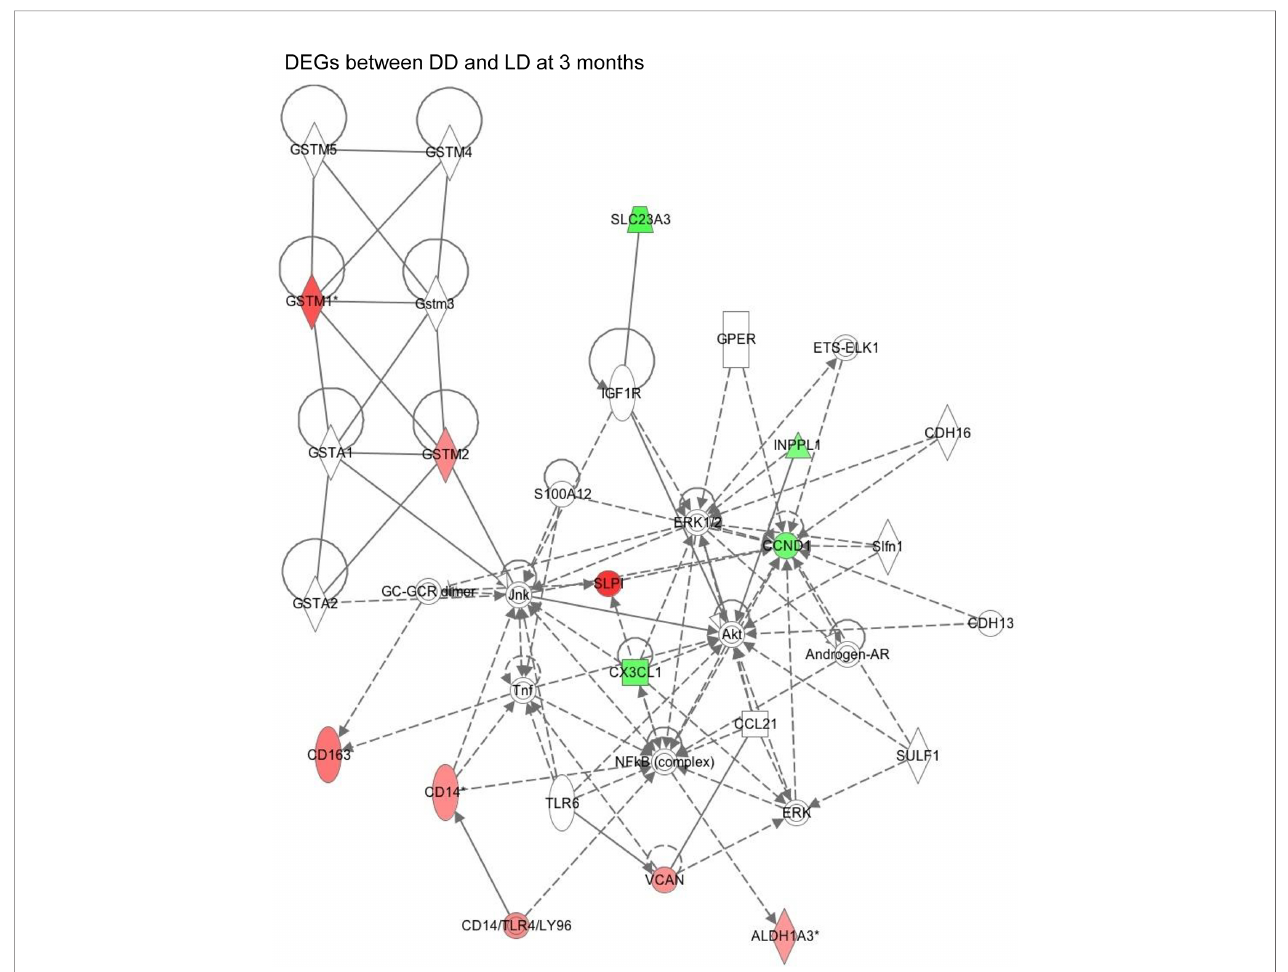
FIGURE 6 | This schematic fi gure demonstrated an example of complicated key network links in DEGs between DD and LD at 3 months generated by function annotation using Ingenuity Pathway Analysis, as well as certain signaling pathways, with red or green color highlighted up or down-regulated